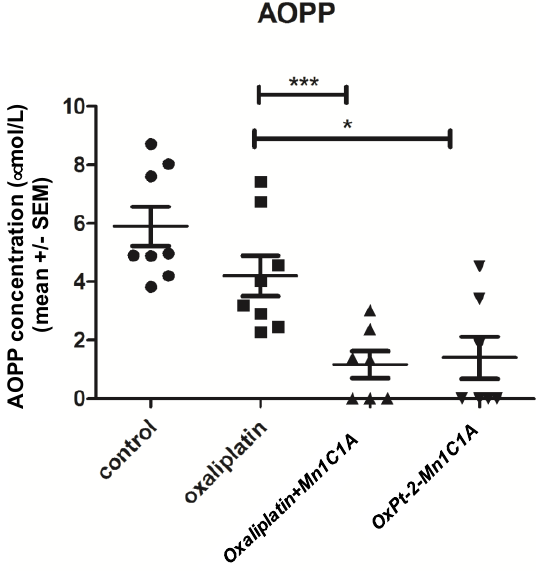
Figure 8. Mean advanced oxidation protein products (AOPP) measured in mice serum. AOPP concentration ( µ mol/L of chloramine-T equivalents). Balb/c mice inoculated with CT26 cells treated by weekly intraperitoneal injection with the vehicle (8 mice), oxaliplatin (8 mice, 10 mg/kg/week), OxPt-2-Mn1C1A (9 mice, 10 mg/kg/week), and Mn1C1A + oxaliplatin (9 mice, 10 mg/kg/week) and sacrificed. In the sera of mice treated with Mn1C1A+ oxaliplatin and with OxPt-2-Mn1C1A, AOPP levels were significantly lower than the vehicle and the oxaliplatin group ( p < 0.05), reflecting seric MnSOD activity. The p -values are denoted as follows: * p < 0.05 and *** p < 0.001.